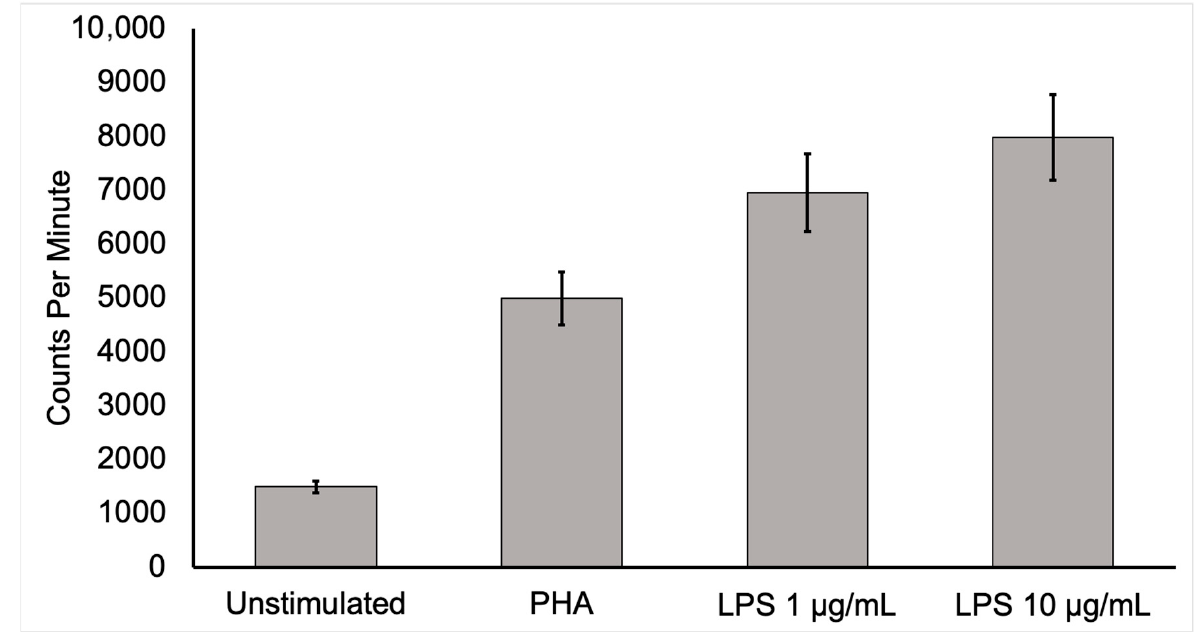
Figure 1. Activated mononuclear cell deoxyglucose uptake. To show that activated inflammatory cells have a higher uptake of [ 18 F]FDG, human mononuclear cells from a healthy, adult male were isolated and cultured for 6 h in media containing [ 3 H]deoxyglucose ([ 3 H]DG) in the absence of stimulants and in the presence of lipopolysaccharide (LPS) or phytohemagglutinin (PHA). After culture, samples were washed three times in phosphate-buffered saline, collected, and placed in a scintillation counter. Mononuclear cells uptake of [ 3 H]DG was several times more in the stimulated state than in the unstimulated control condition. This in vitro study supports the conclusion that active inflammatory cells dramatically increase [ 18 F]FDG uptake. Moreover, highly increased [ 18 F]FDG uptake by activated inflammatory cells at infection sites is likely to allow the detection of infection by this technique.